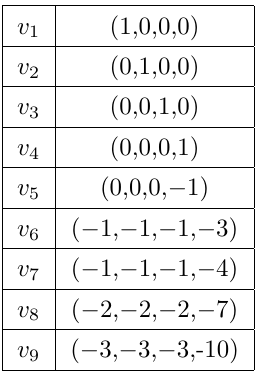
Table 5 . The rays on the toric fourfold base B 4 of the elliptic Calabi-Yau fourfold in P 1 , 3 , 3 , 3 , 10 , 40 , 60 , with Hodge numbers ( h 1 , 1 , h 2 , 1 , h 3 , 1 , h 4 , 1 ) = (7 , 3 , 171 , 53 192)